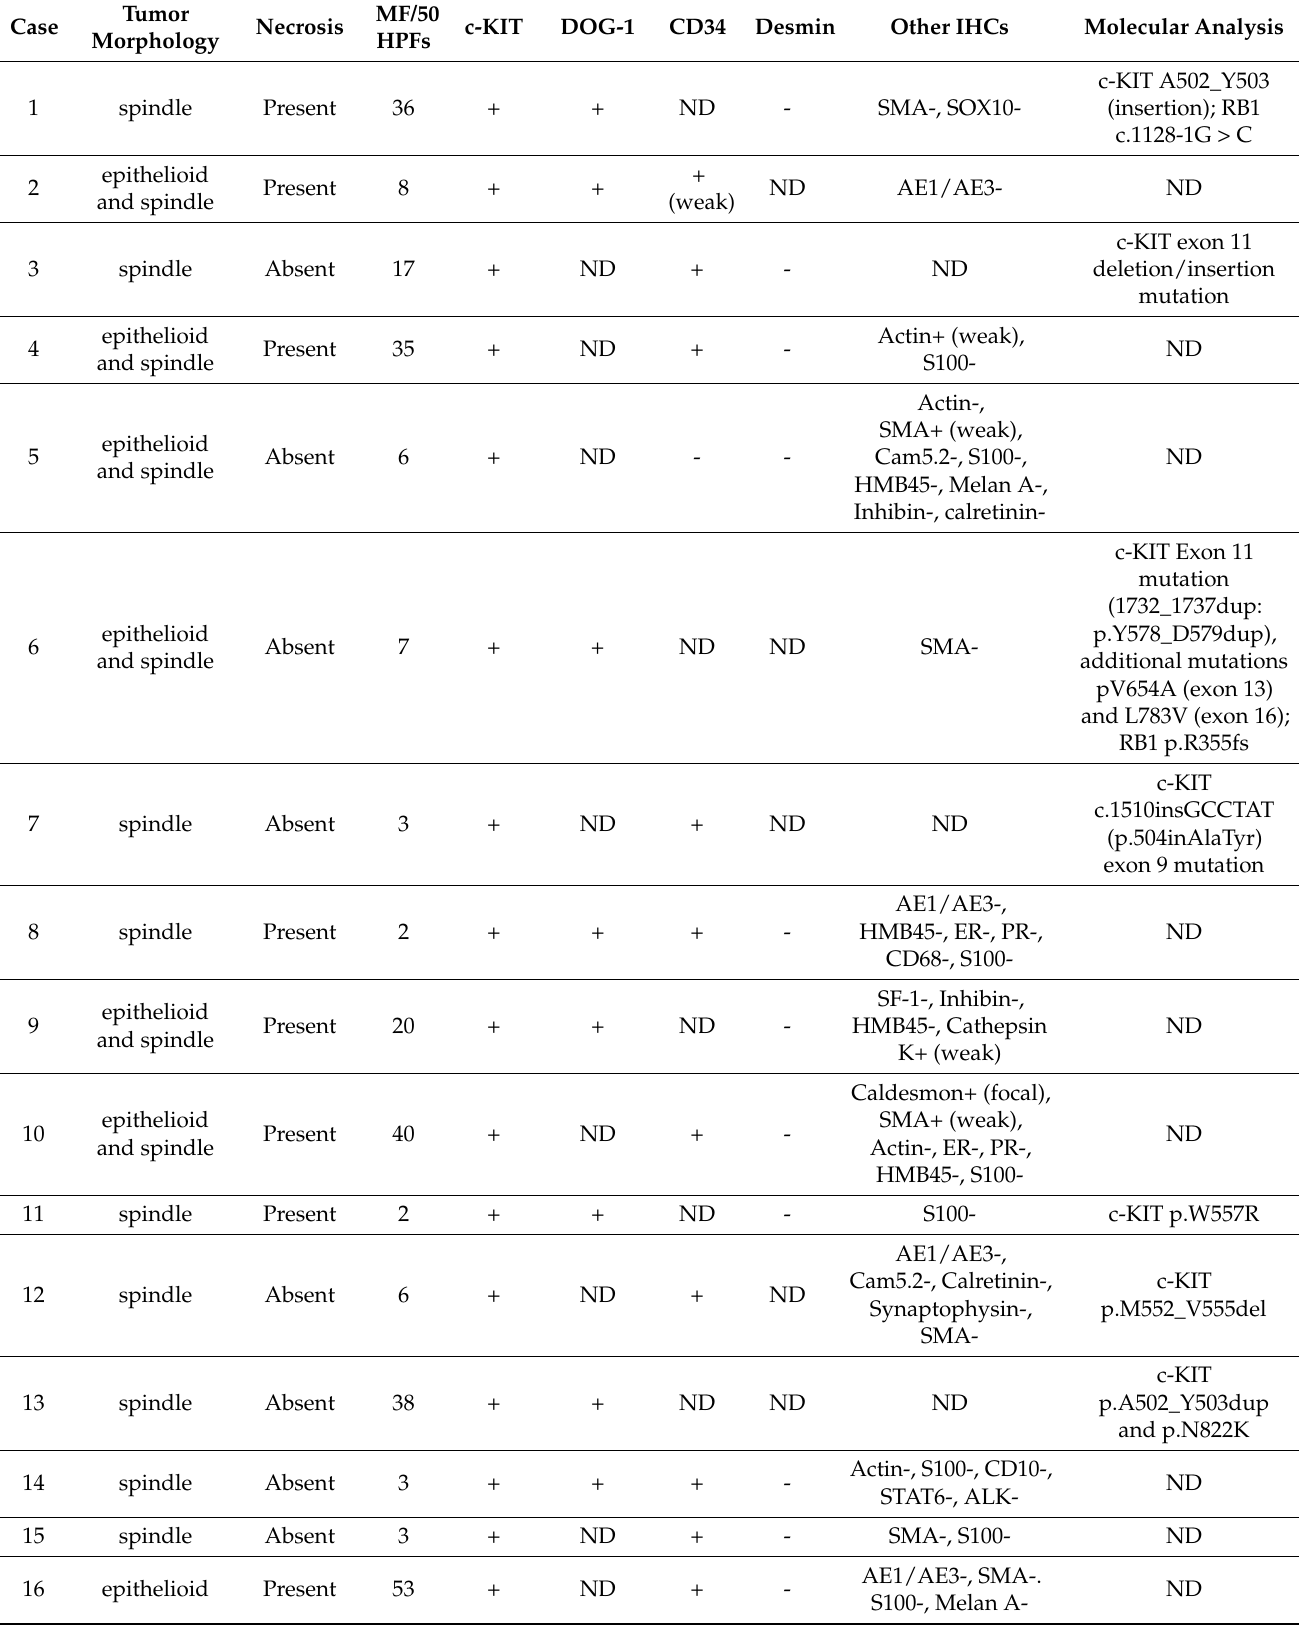
Table 2. Morphology, immunohistochemistry, and molecular